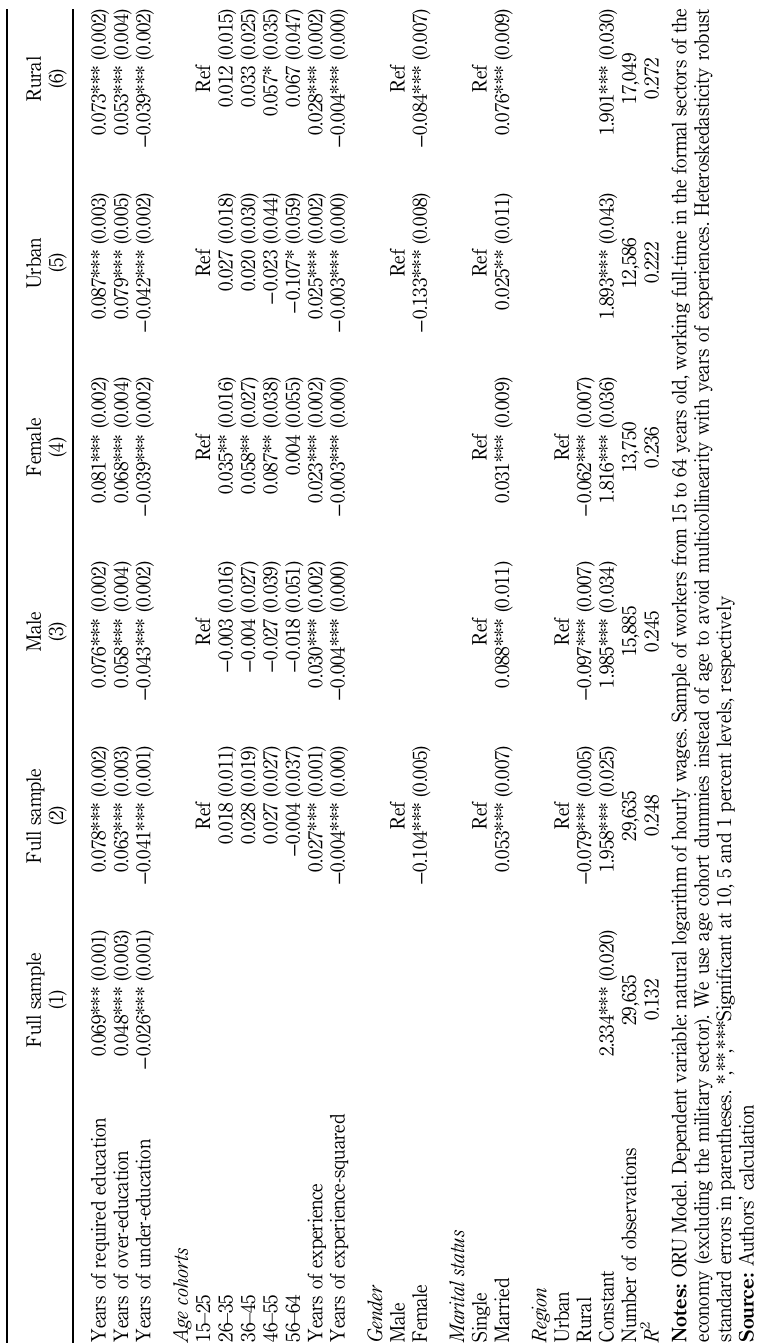
Table III. Qualification mismatch and impacts on earnings –